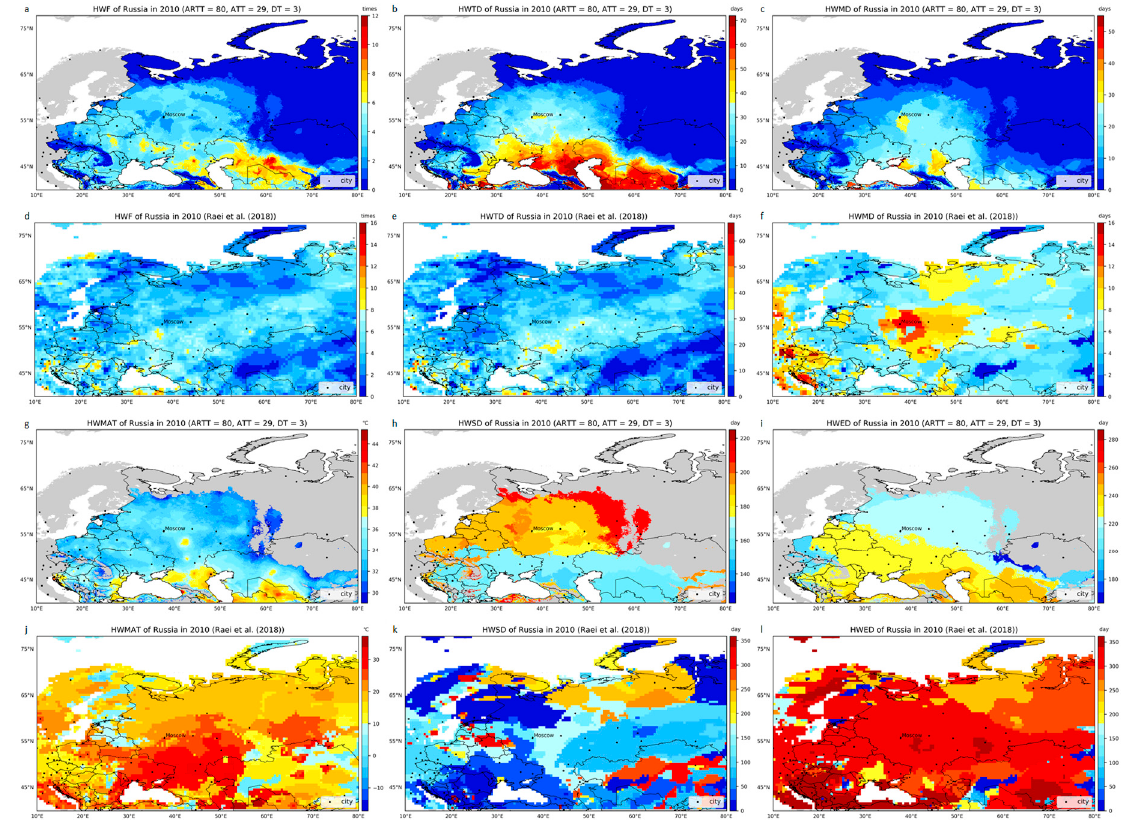
Figure 10. Comparison with other results: ( a – c , g – i ): HWF, HWTD, HWMD, HWMAT, HWSD, HWED under ARTT = 80, ATT = 29 and DT = 3; ( d – f , j – l ): HWF, HWTD, HWMD, HWMAT, HWSD, HWED (Raei et al. (2018)).